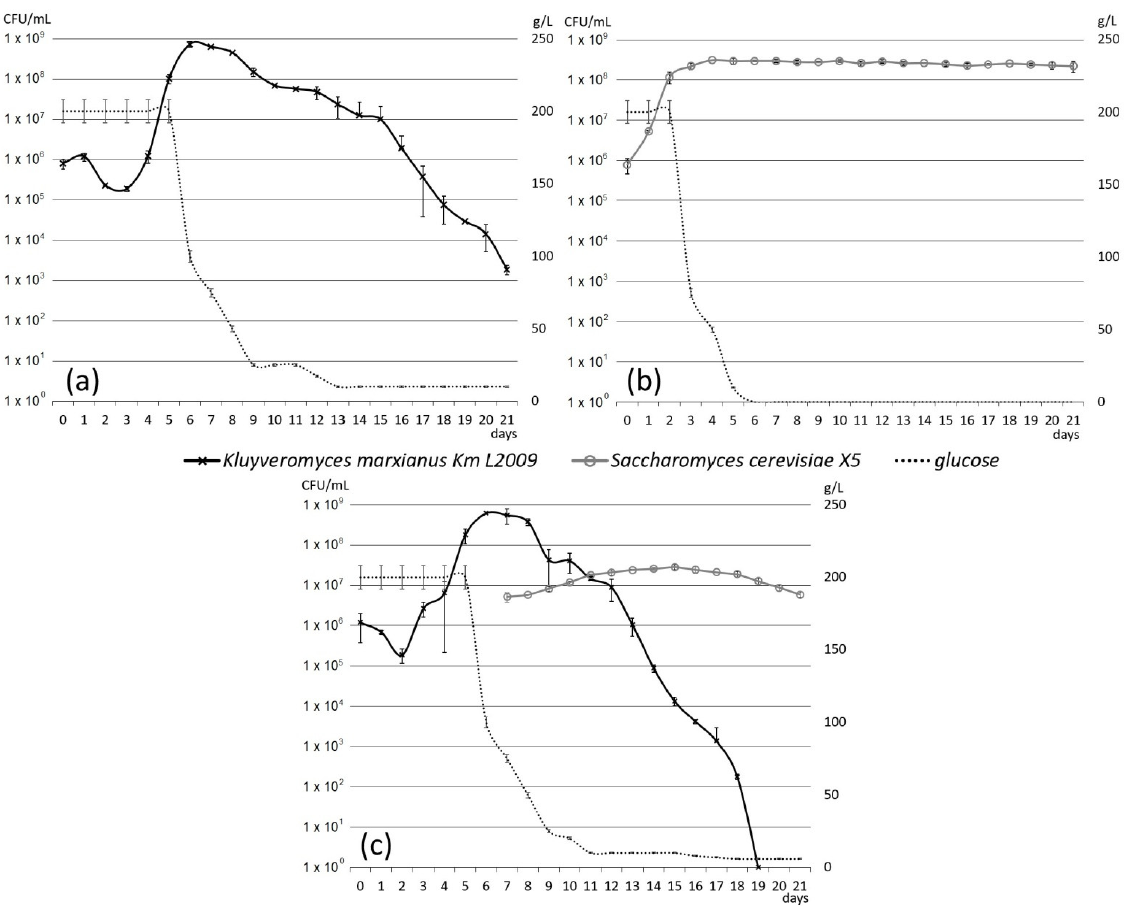
Figure 2. Growth in sterile must of K. marxianus strain Km L2009 alone ( a ), of S. cerevisiae strain Zimaflore ® X5 alone ( b ) and of the two strains inoculated sequentially ( c ). Each graph shows the days of fermentation on the horizontal axis, the CFU/mL of the yeast strains on the left vertical axis and the g/L of glucose on the right vertical axis. Table 2. The main chemical-physical parameters and statistical data analysis of the laboratory-scale fermentations. Data are reported as average values ± standard deviations of two different vinifications, each with measurements in triplicate.